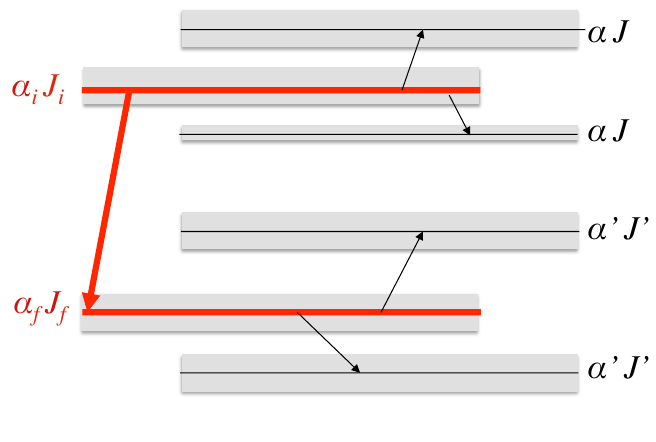
Figure 1. The studied line, i − f (red-bold arrow, example of an emission line): α J the initial level, and α is the final level. The perturbing levels are αJ , α (cid:48) J (cid:48) . Black-thin f f arrows: the inelastic transitions in excitation and deexcitation. The levels are broadened (grey strips), but do not